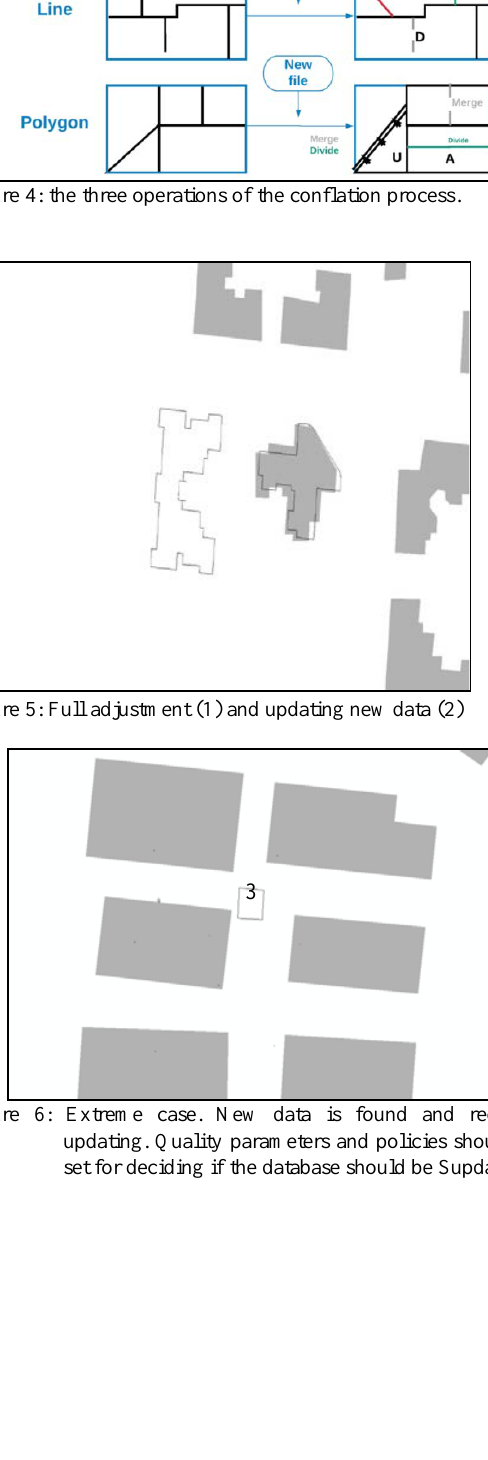
Table 2: number of check point for RMSE calculation.